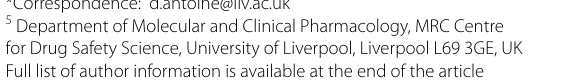
Fig. 1 trace A2 and A3, the traces have been